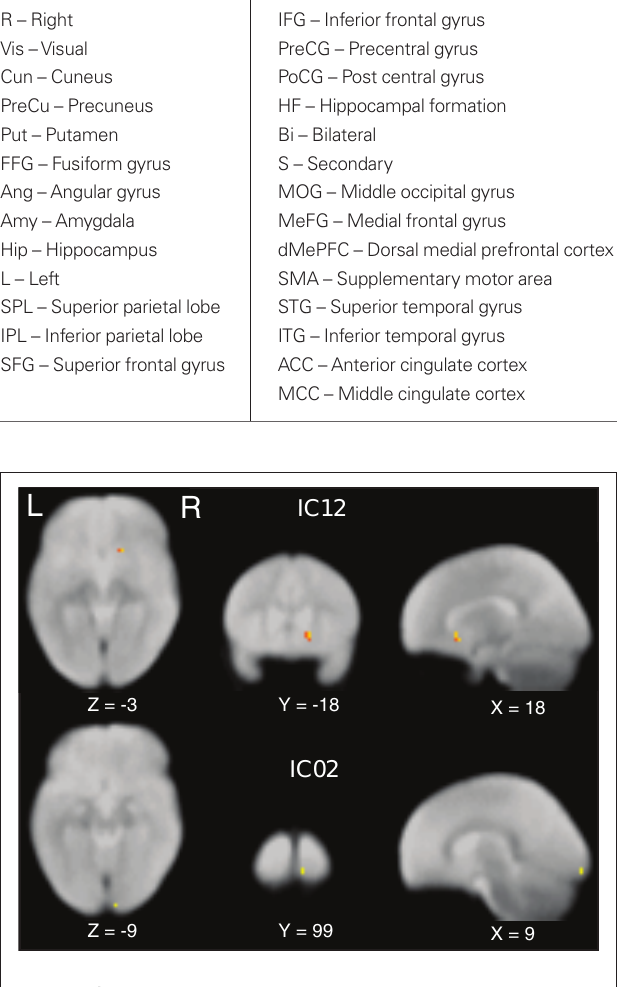
Figure 2 | independent component maps depicting significant age related differences in two sample random effects analysis. Maps are thresholded at a whole brain voxelwise FDR corrected p < 0.05.